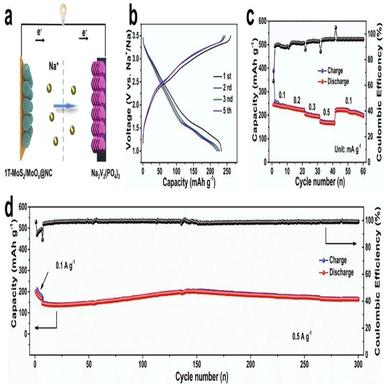
(a) Schematic illustration of 1 T-MoS2/MoOx@NC//Na3V2(PO4)3 full cell, (b) charge and discharge profiles at 0.2 A g− 1 , (c) rate performance, and (d) cycling performance at 0.5 A g− 1 .